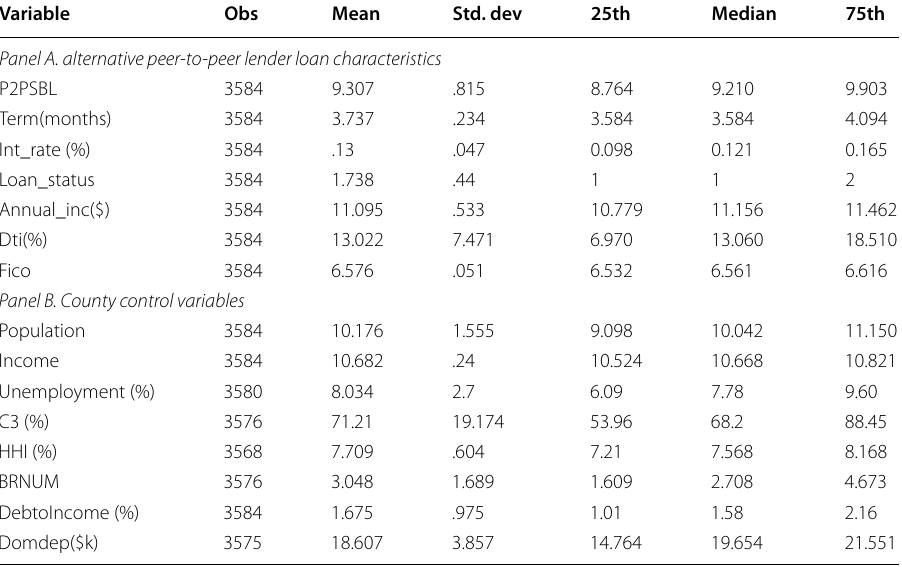
Table 4 Descriptive statistics for alternative P2P lender at